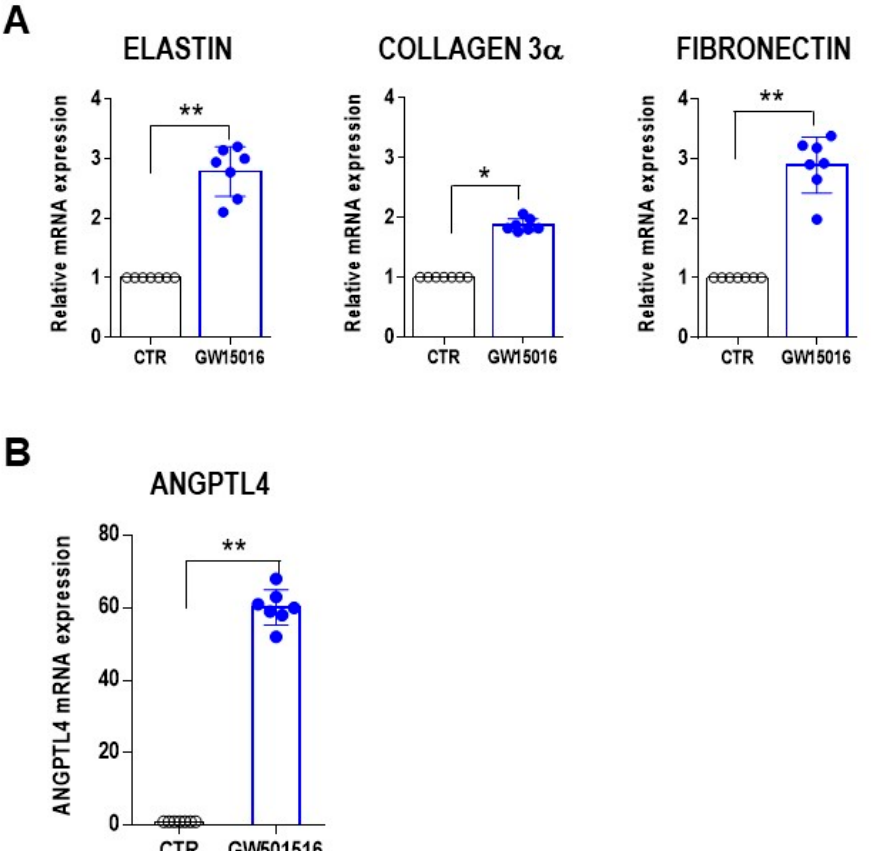
Figure 5. Promotion of extracellular matrix remodeling and ANGPTL4 expression in MMEC treated with a PPAR β / δ agonist. ( A , B ) Relative mRNA levels of ( A ) elastin, collagen 3 α , fibronectin, and ( B ) ANGPTL4 in MMEC cultured in serum-free medium alone (CTR) or containing 10 nM GW501516 for 12 h. The values were normalized to those of the control and were determined by real-time PCR and the 2 − ∆∆ Ct method based on seven independent experiments. * p < 0.05, ** p ≤ 0.01, Mann–Whitney